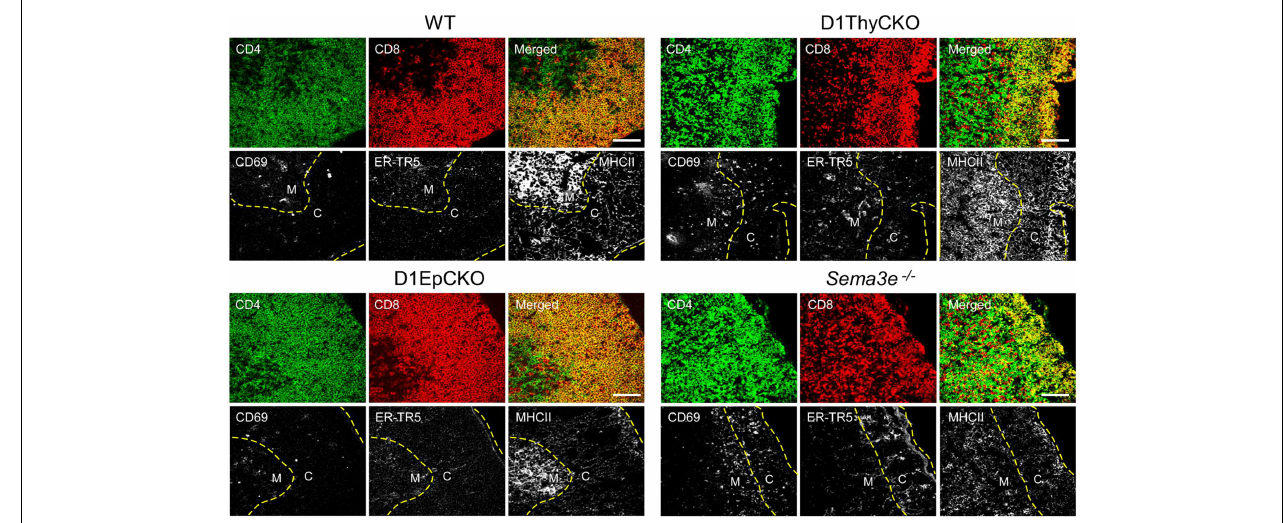
line is inserted to indicate the apparent corticomedullary junction. A second yellow dashed line indicates the capsule position. CD69 is an activation marker expressed by positively selected thymocytes followingTCR stimulation. ER-TR5 is considered a medullary marker (29) while MHCII (I-A/I-E) is preferentially expressed in medulla (30). Each figure is representative of three independent experiments.White bar in the merged images is 100 µ m.